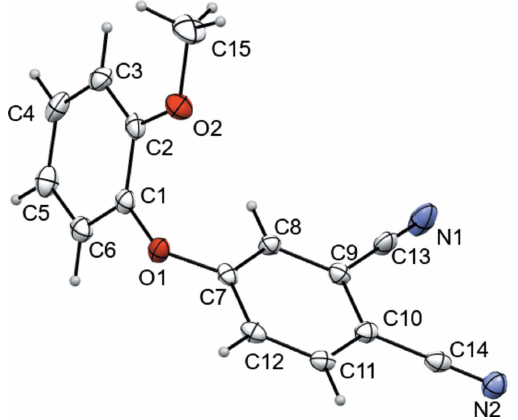
Figure 3 The molecular structure of the o -4-(2-methoxyphenoxy) phthalonitrile dimer, linked by C–H (cid:4)(cid:4)(cid:4) N hydrogen bonds. Displacement ellipsoids are drawn at the 50% probability level.